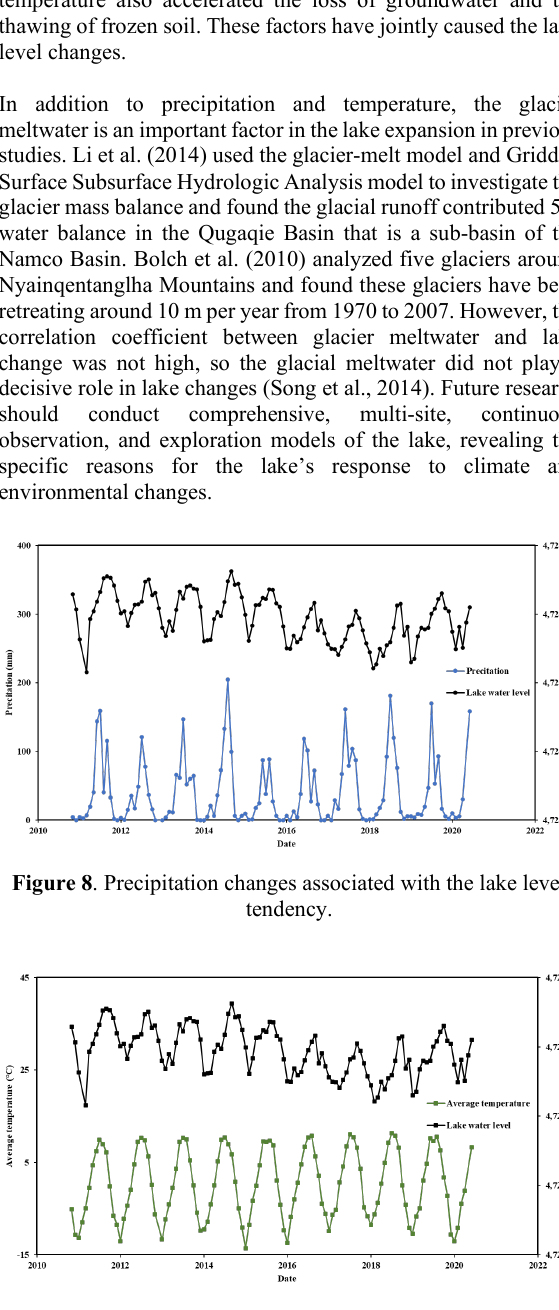
Figure 9 . Temperature changes associated with the lake level